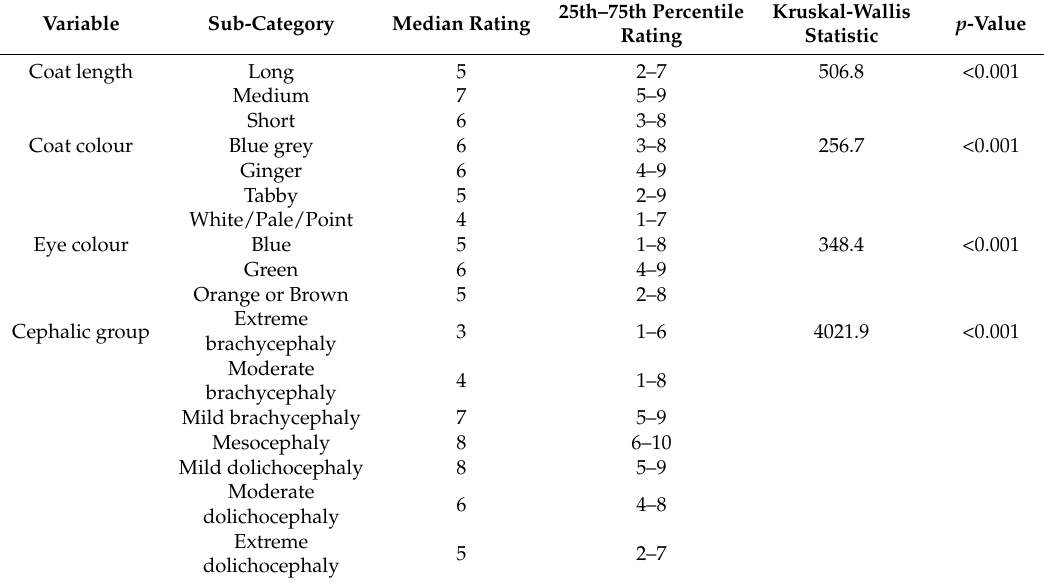
Table 2. Results of univariate analyses of associations between physical characteristics of 15 cats presented within two questionnaires as photographs (as per Table 1) and owner ( n = 1239) preference ratings (0 = “I don’t like this cat at all”; 5 = neutral; 10 = “this is my favorite type of